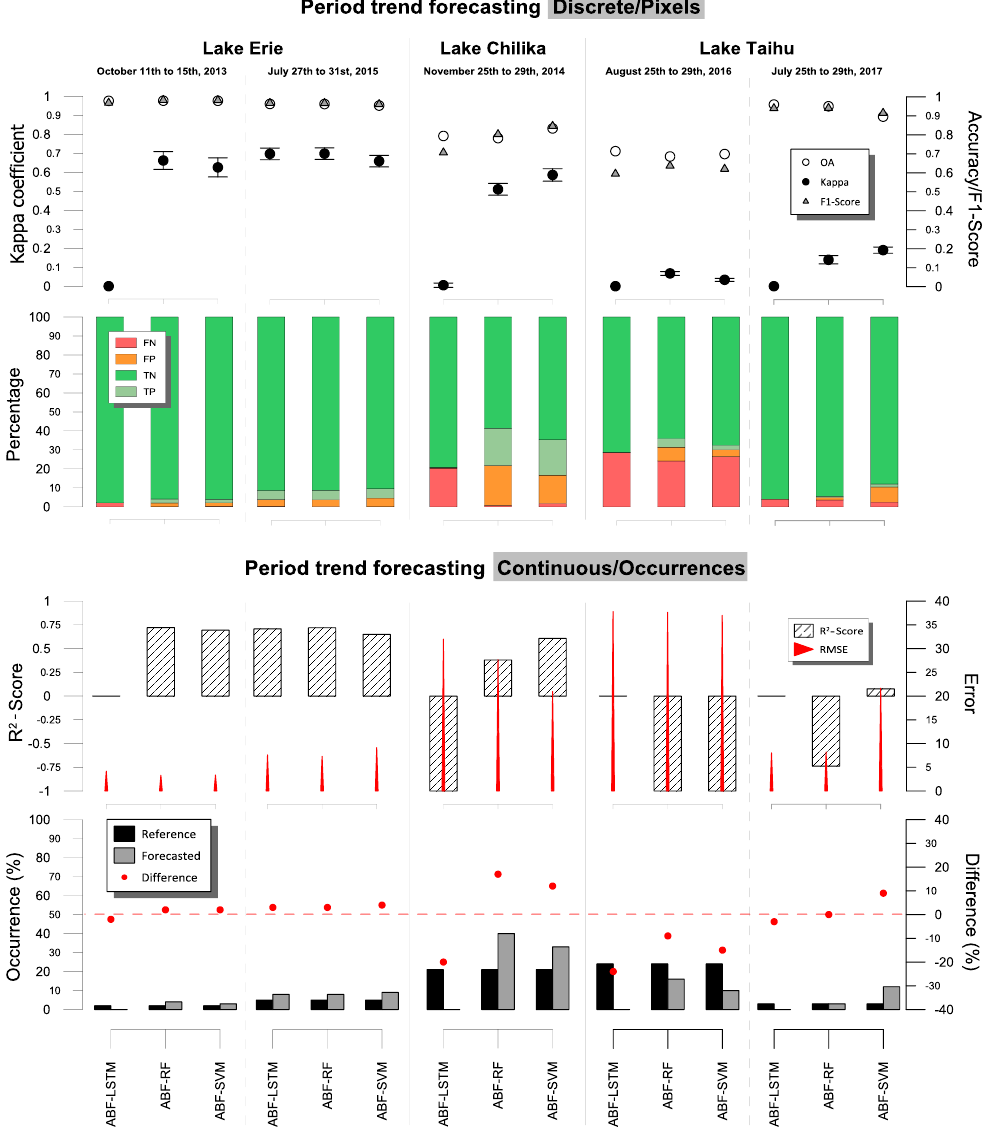
Figure 11. Quantitative assessment of the forecasting models. The first plot shows the global accuracy, F1-Scores and kappa coefficient values, whereas the second one shows the performance of each model based on their True(T)-False(F)/Positive(P)-Negative(N) scores. The third plot compares the models by means of R 2 -Scores and RMSE measures. Finally, the last plot lists the predicted/referenced occurrence percentages. Dashed red line represents the value where the difference was